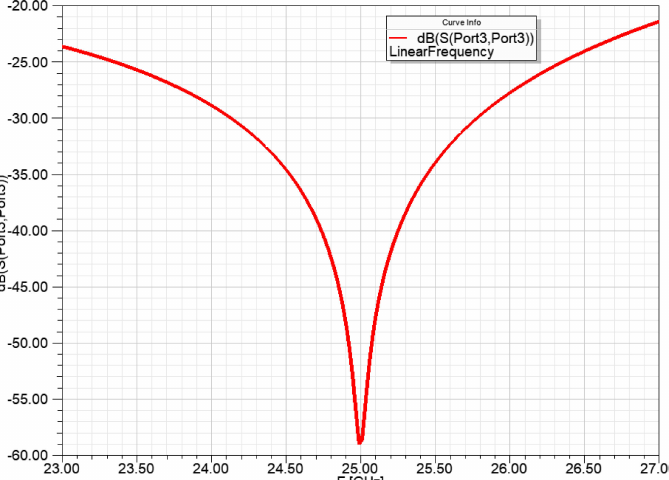
Figure 11. Input reflection of the power division network for a 1 to 4 power ratio, with ideal transmission lines.